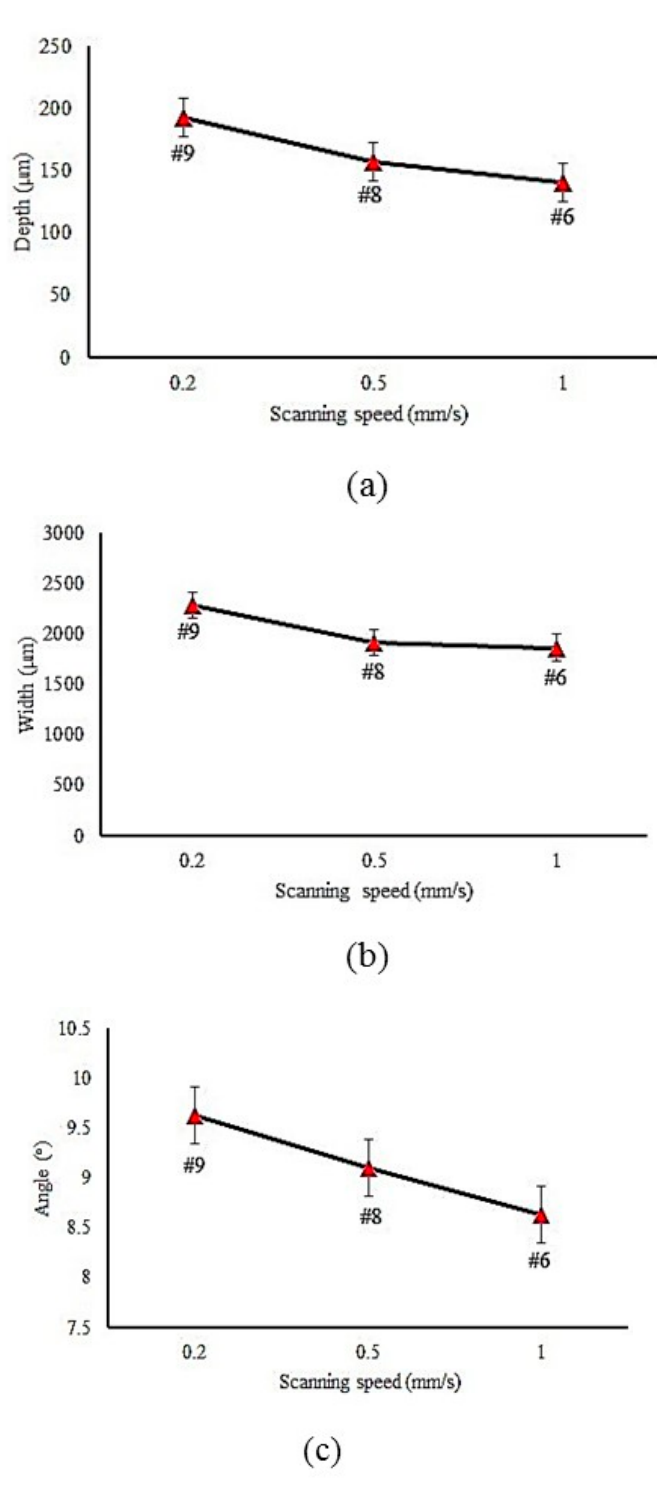
Figure 7. Influence of the laser scanning speed (LSS) on LH profile geometry. ( a ) LSS on depth (samples #6, #8 and #19); ( b ) LSS on width (samples #6, #8 and #9); ( c ) LSS on angle (samples #6, #8 and #9).